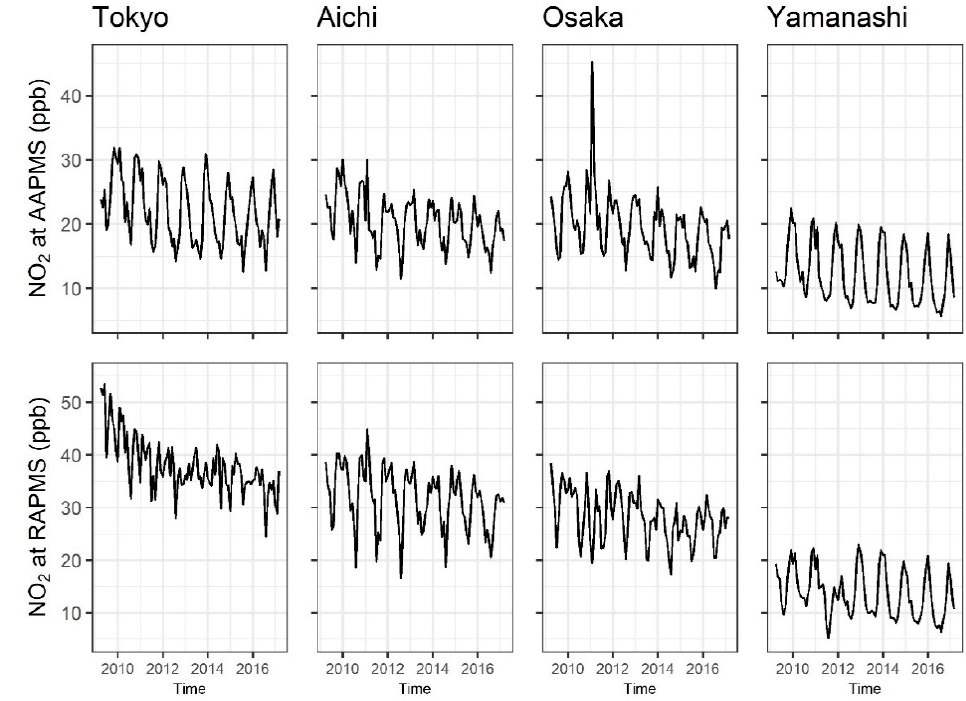
Figure 1. Monthly average nitrogen dioxide (NO 2 ) concentration in April 2009–March 2017 in the study areas, Tokyo, Aichi, Osaka, and Yamanashi, Japan. Upper figures are NO 2 concentrations at ambient air pollution monitoring stations (AAPMSs) while lowers are at roadside air pollution monitoring stations (RAPMSs).